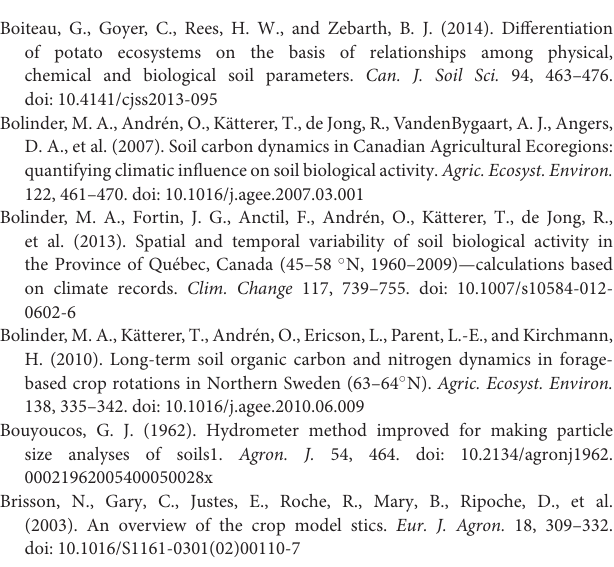
Supplementary Material 1 | R code and data archive at https://github.com/ essicolo/site-specific-multilevel-modeling-of-potato-response-to-nitrogen-